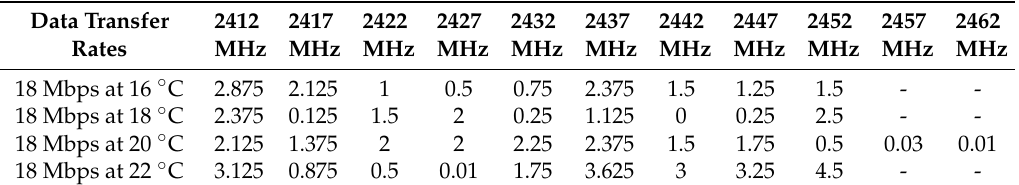
Table 14. Calculation of residuals for OFDM at 18 Mbps.